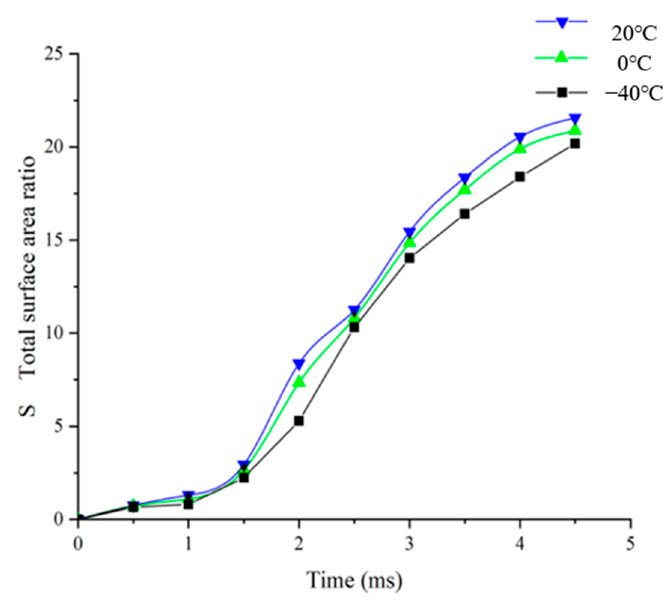
Figure 8. Comparison of the total surface area ratios at different temperatures .